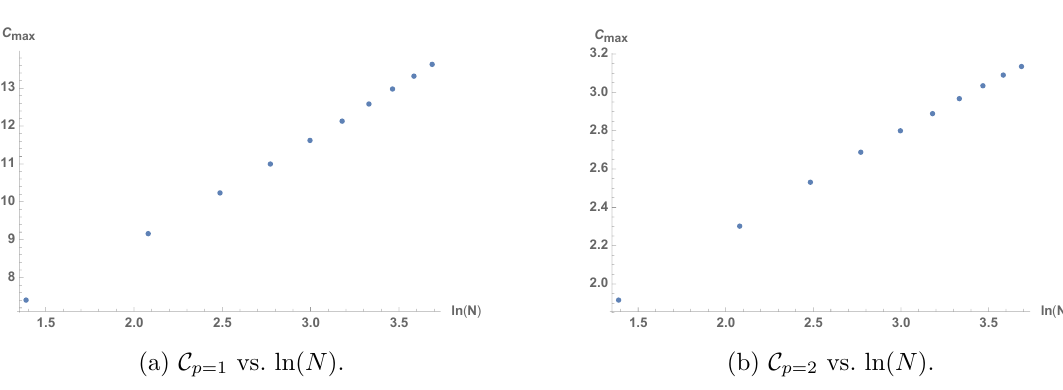
Figure 6. The maximum complexity for the fermionic case grows w.r.t. the logarithm of the cuto(cid:11), linearly for the p = 1 norm and quasi-linearly for the p = 2